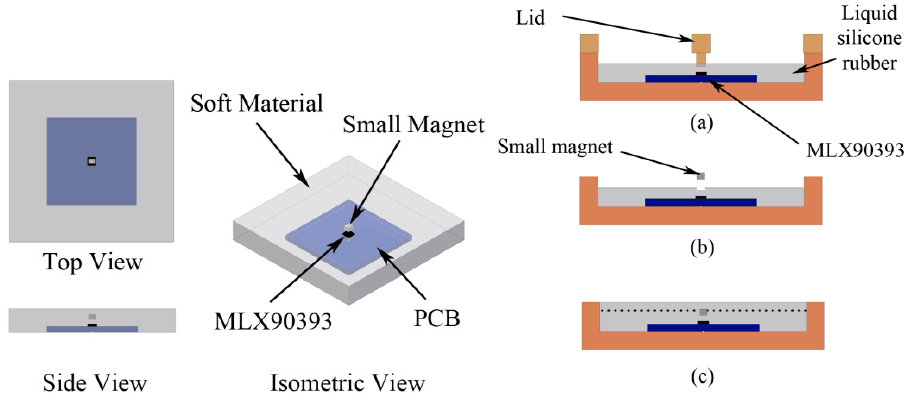
Figure 1. Conceptual design (left) and the molding process (right). ( a ) Liquid silicone rubber was poured into the molding cast; ( b ) A small magnet was placed inside the hole; ( c ) More liquid silicone rubber was poured above the first layer to cover the small magnet.